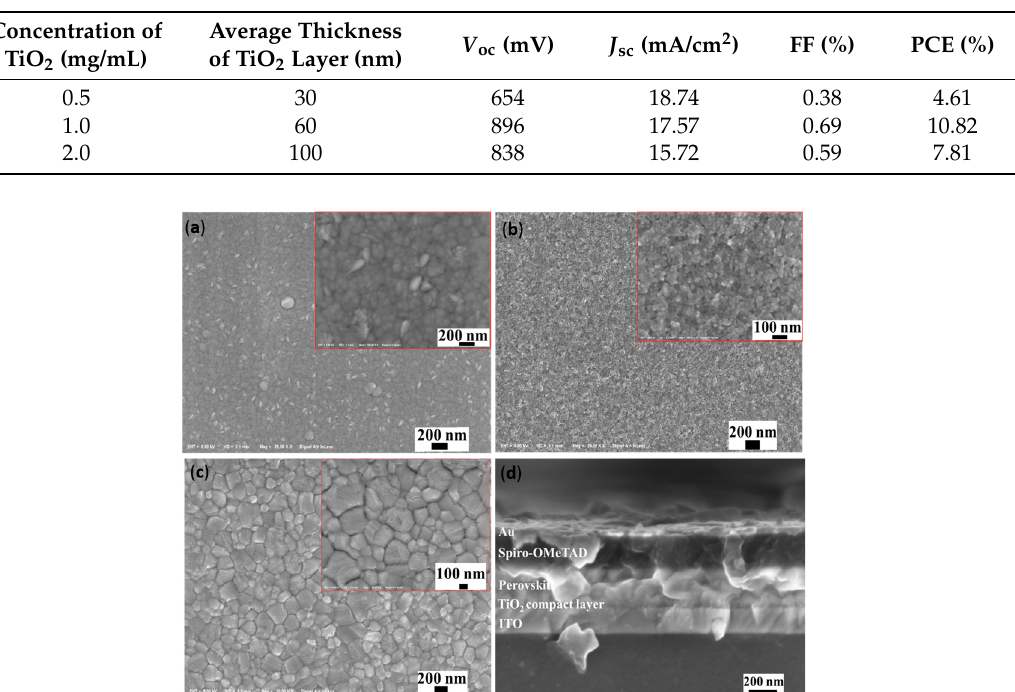
Figure 4. Scanning electron microscopy (SEM) image of ( a ) PEN-ITO substrate; ( b ) TiO 2 compact layer; ( c ) perovskite prepared by the gas-assisted method; and ( d ) cross-section SEM image of the PSCs.